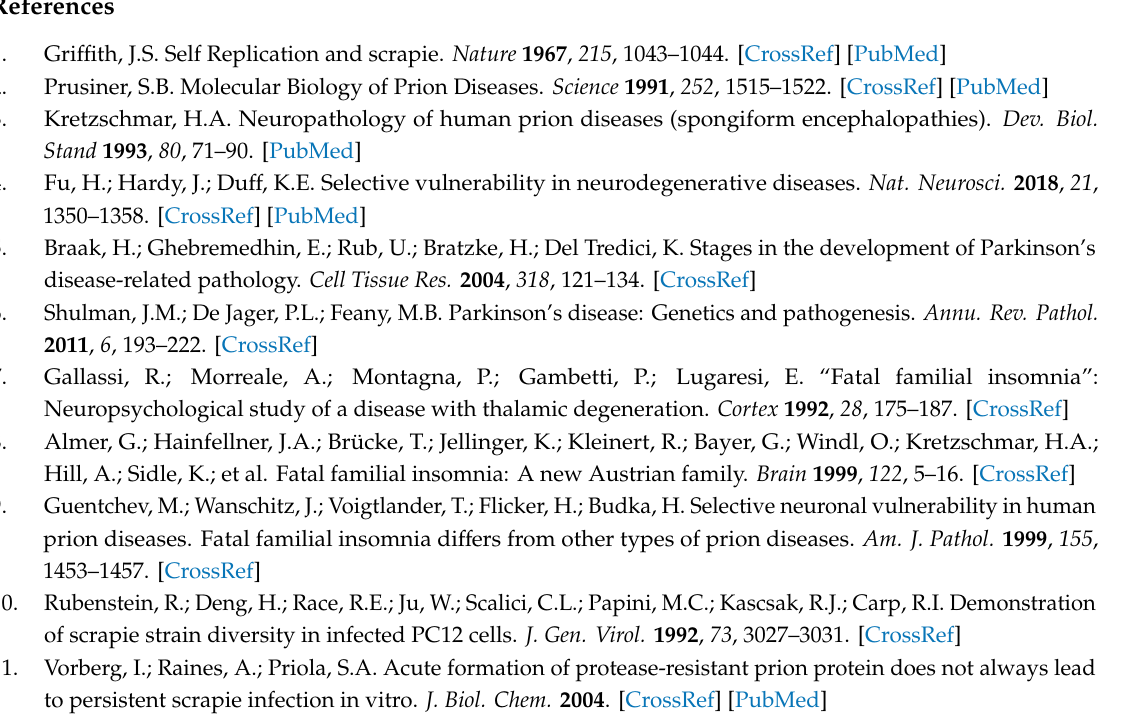
Table S1: Changes in likelihood of isolating susceptible and refractory cells from generation 1 to generation 3. Table S2. Infectious titers of embryonic cortico-hippocampal cultures from FVB wt (Prnp +/+ ) and FVB ko (Prnp − / − ) mice, infected with RML, Me7, PME2-6D8 and uninfected CD1. Figure S1: Neuronal degeneration in mixed cortico-neuronal cultures. Figure S2: Characterization of chronically Me7 and RML infected PME2 cells with respective brain